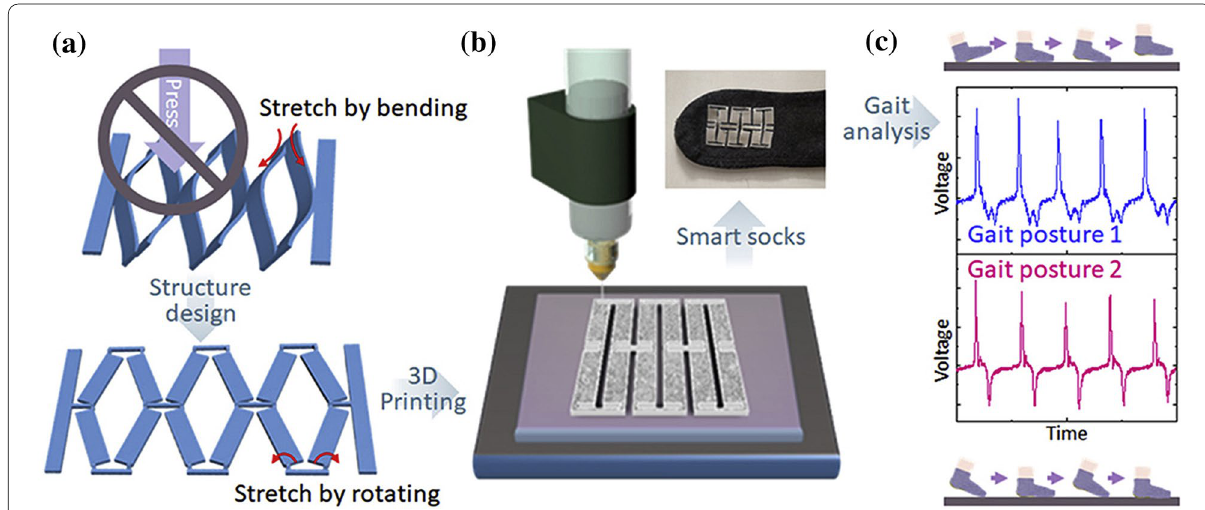
Fig. 10 a 3D printed PENG with the kirigami structure b fabrication of 3D-printed PENG c output voltage of the printed PENG-integrated socks under different foot-stamping postures [34] (Images are re-used with the permission of the publisher)